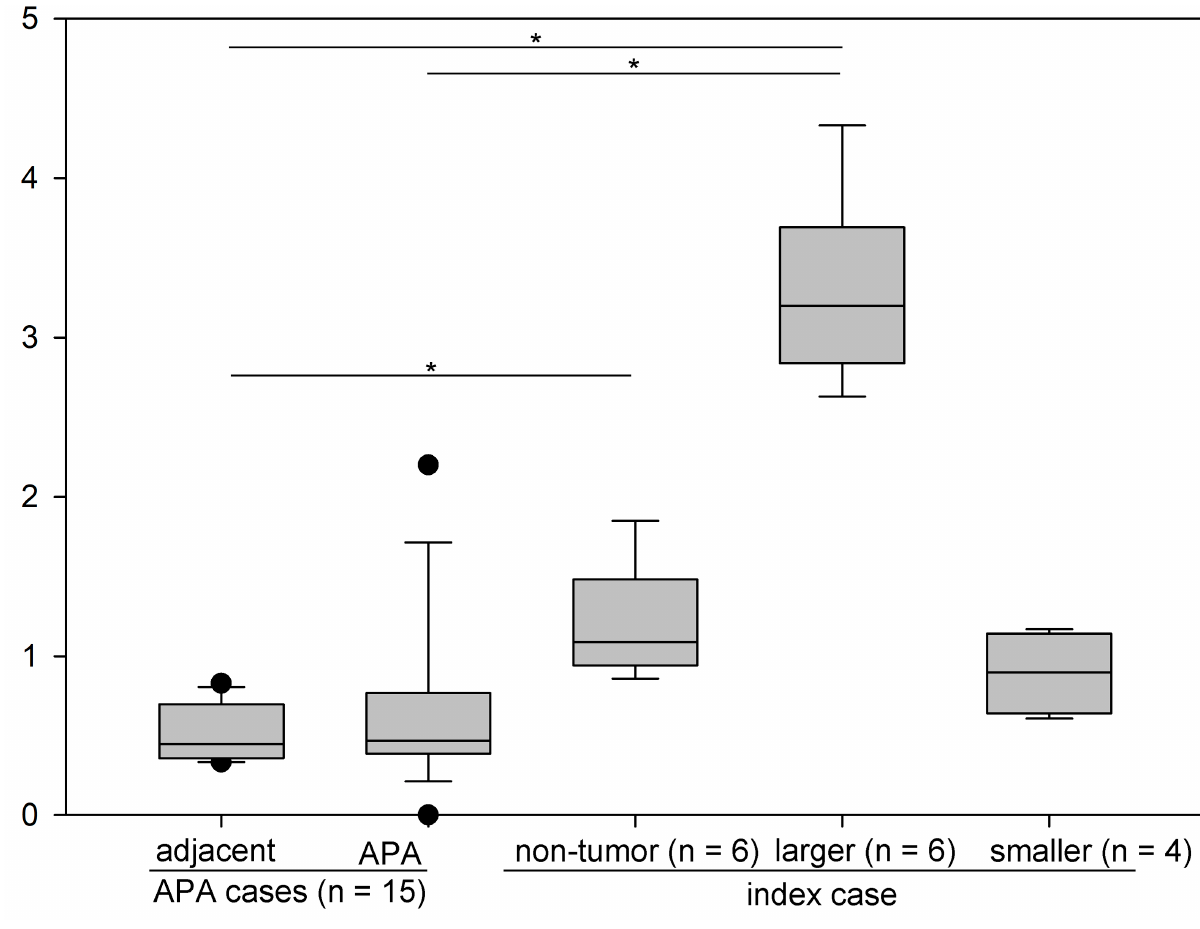
Figure 3. Comparison of Ki-67 index among APA cases ( n = 15 each) and index case. * p <